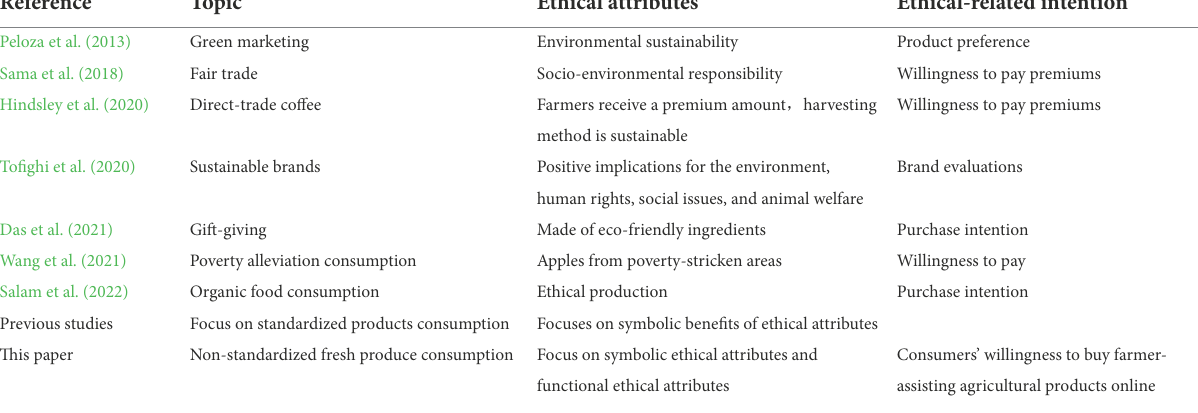
TABLE 1 Literature on ethical